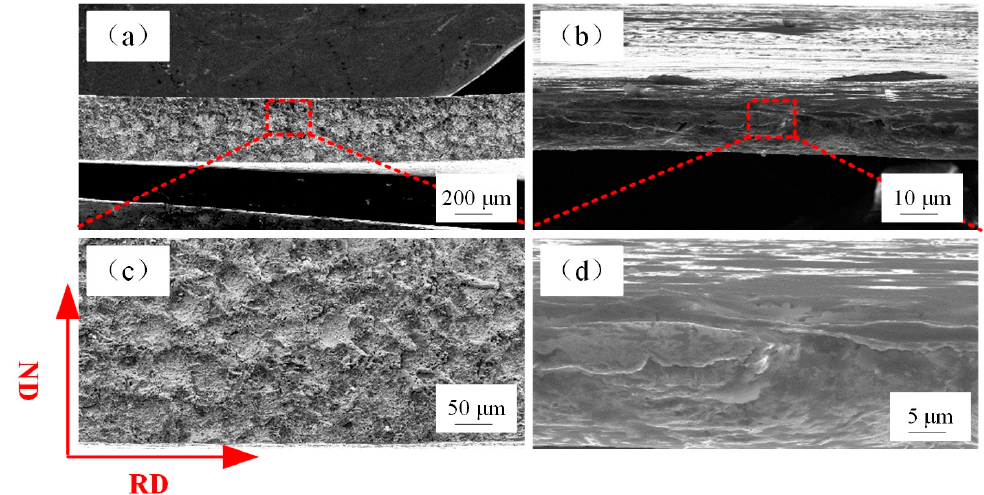
Figure 7. Cross-sectional photographs of fracture position with sample thickness of ( a ) 600 µm, ( b ) 20 µm, where ( c ), ( d ) are an enlarged view of the dotted rectangle in (a), (b).